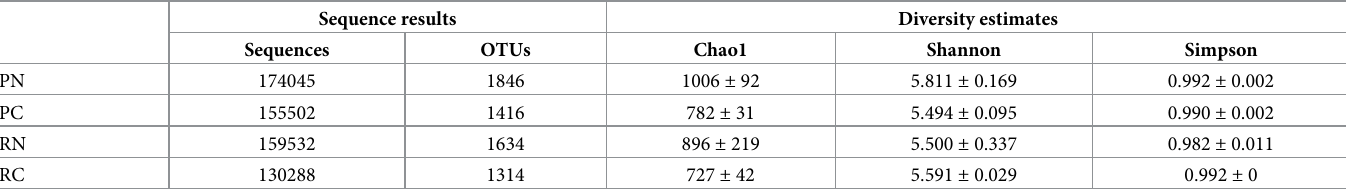
Table 2. 16S rDNA sequencing results and diversity estimates for each sampling